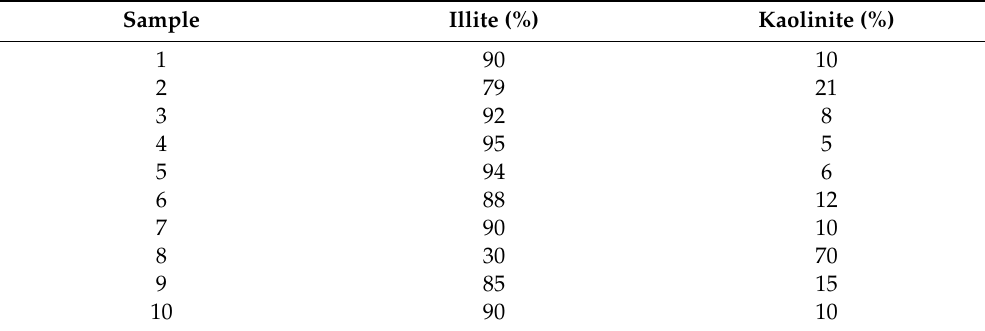
Table 3. Mineralogical composition (%) of clay mineral from B horizons by XRD. Sample Illite